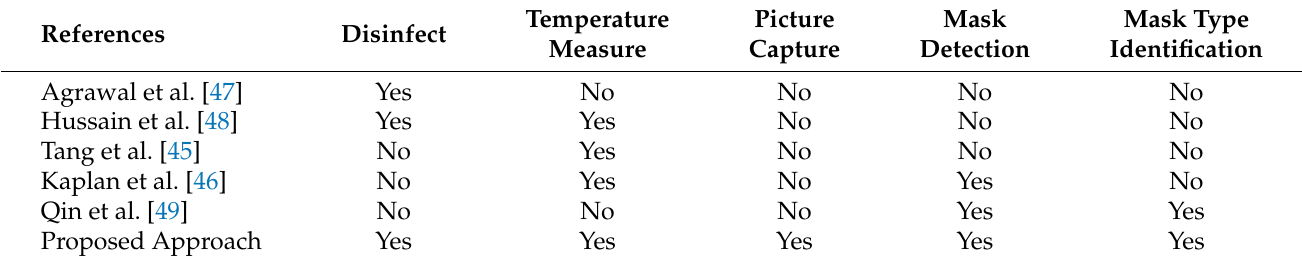
Table 12. Result comparison with prior study and proposed